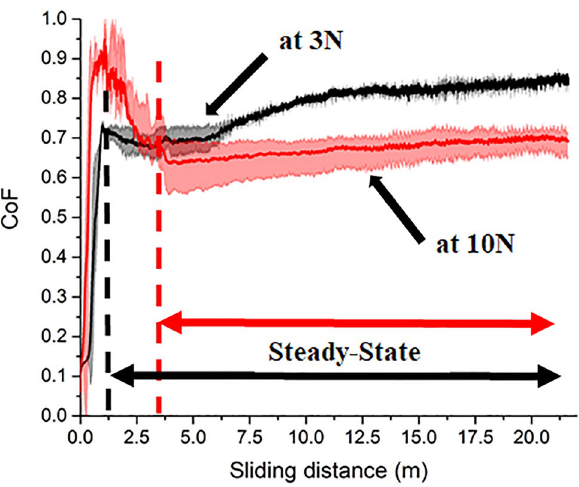
Figure 3. The coefficient of friction against the sliding distance of EBM-processed HCMSS samples at 3 N and 10 N; steady-state stages are annotated for each